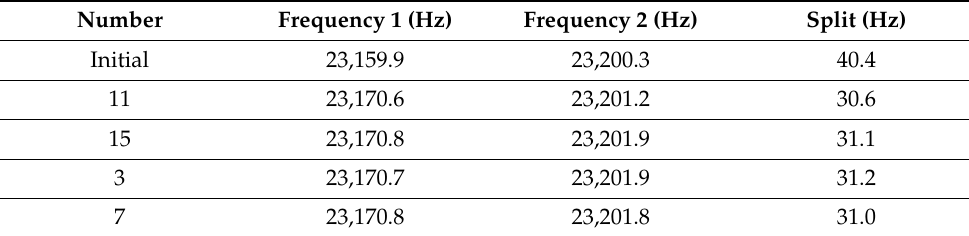
Table 1. Record of the frequency split for different tuning positions at 90 ◦